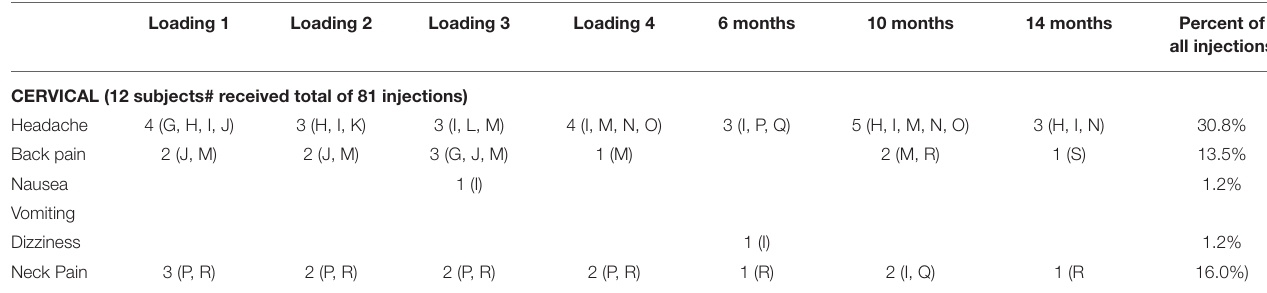
TABLE 3 | Adverse events lumbar